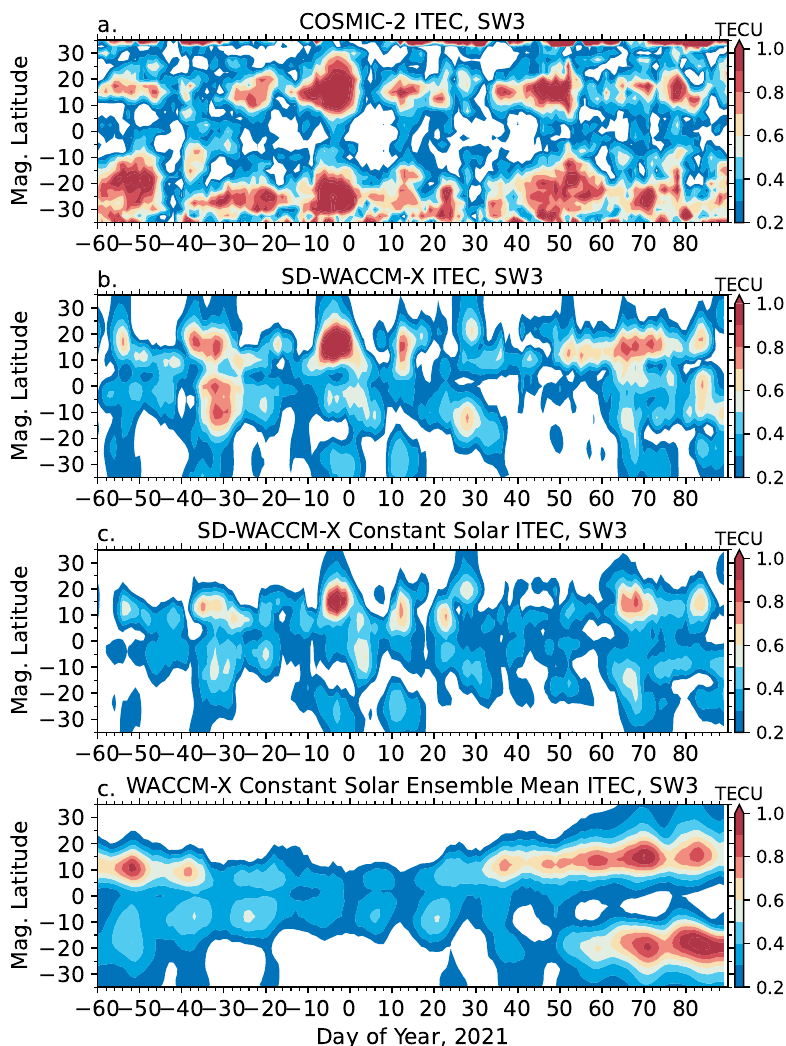
Figure 7. SW3 amplitude in ITEC from ( a ) COSMIC-2 observations, ( b ) SD-WACCM-X, ( c ) SD- WACCM-X Constant Solar, and ( d ) WACCM-X Constant Solar Ensemble